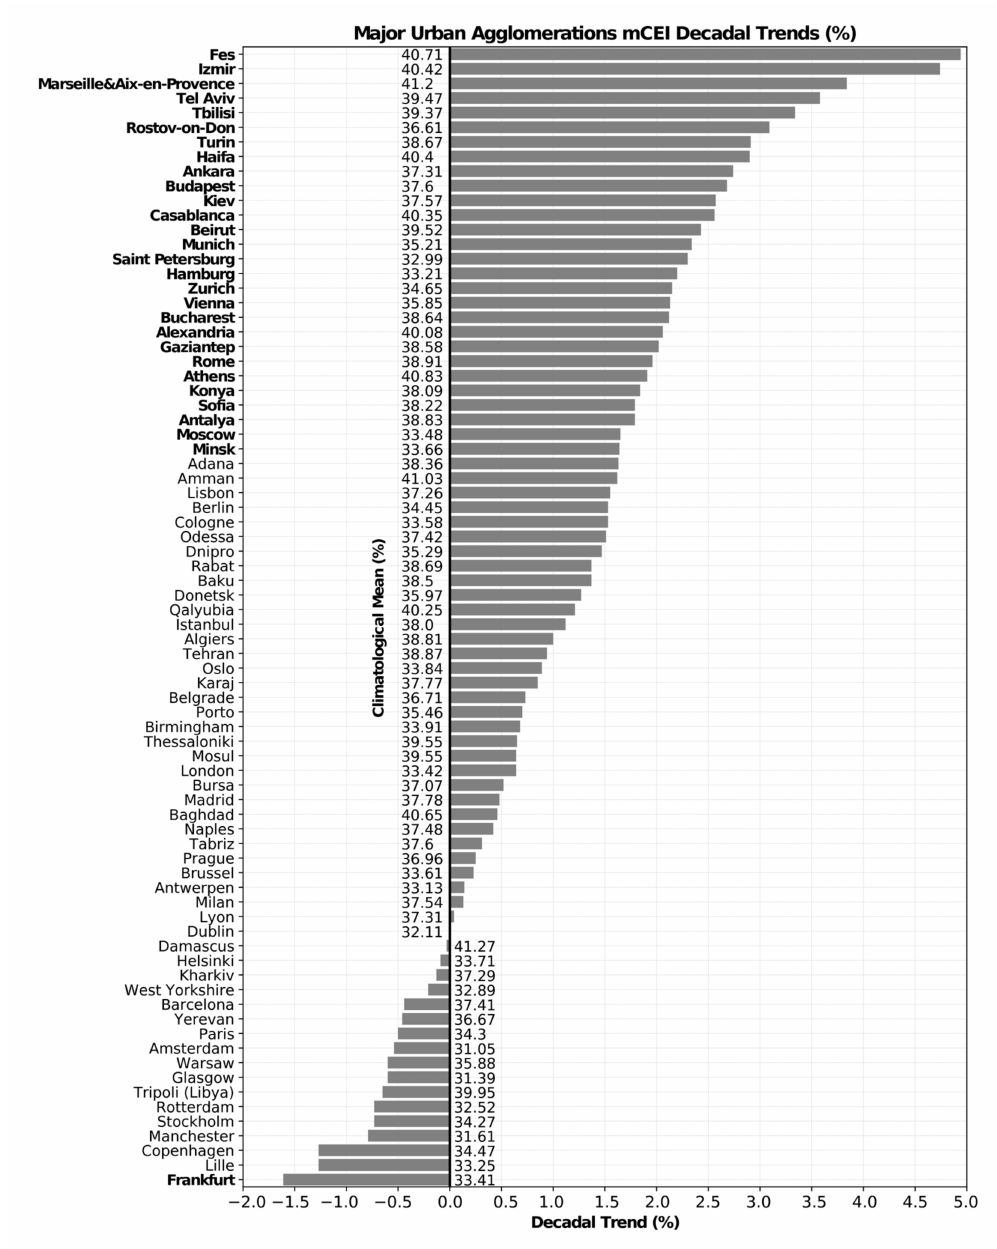
Figure 15. City-based decadal trends and climatological means of mCEI over the major urban settlements of the EURO–MED region. Boldface city name indicates a statistically significant trend at 95% confidence